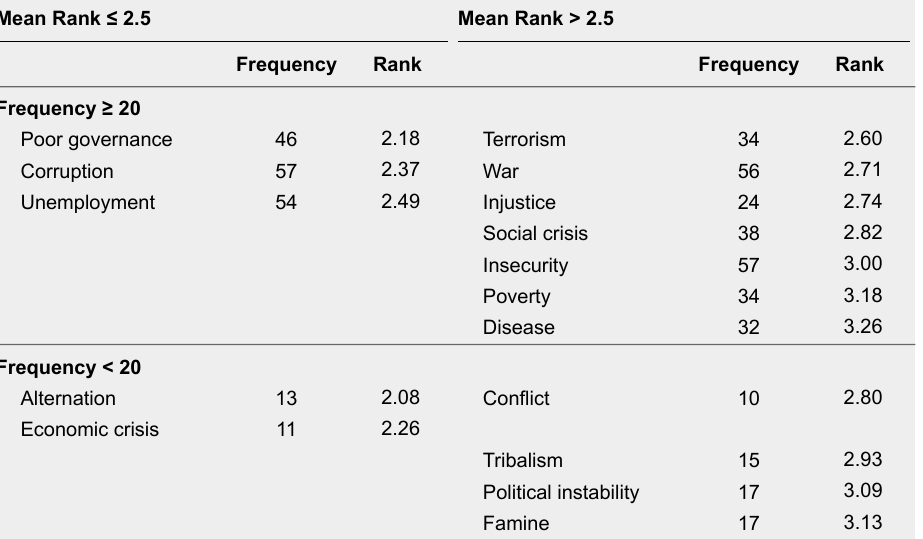
Structure of Risk Representation According to Free Association Analysis (EVOC)